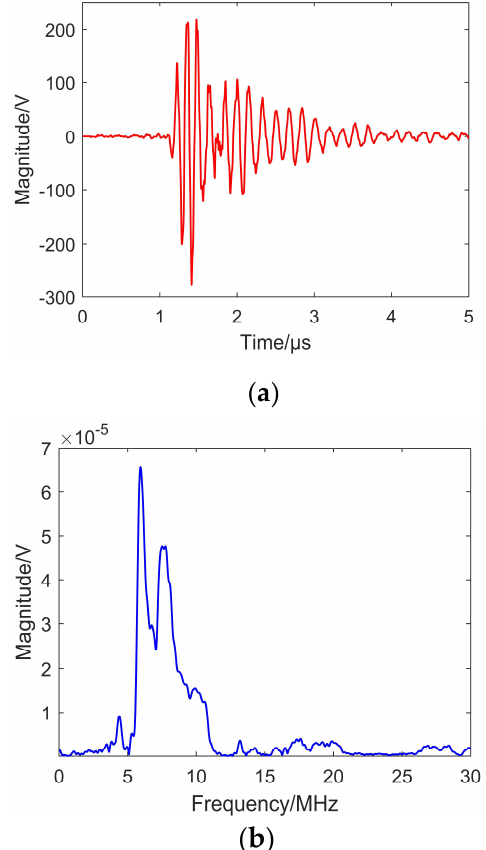
Figure 6. Secondary cable radiation disturbance voltage. ( a ) Time domain waveform; ( b ) spectrogram.